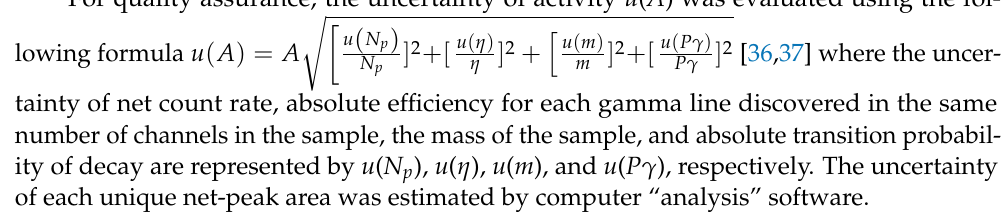
( b ) Figure 2. Field photographs reveal ( a ) cavernous weathering of syenogranite at W. Seih-Sidri; and ( b ) pegmatites at W. Sidri, southwestern Sinai, Egypt.